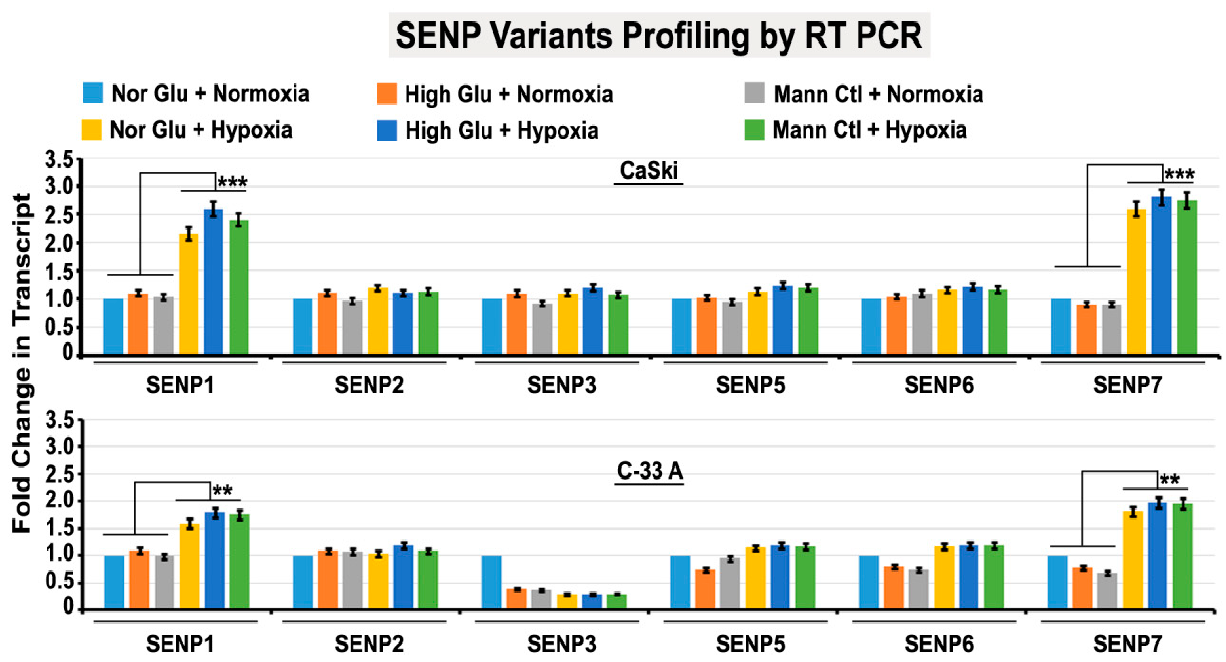
Figure 9. Acute hypoxia upregulates SUMOylation regulatory proteins SENP1 and SENP7. Tumour cells were subjected to the basic treatment conditions for 96 h. Real-Time-PCR-based data showed a significant upregulation in the transcript of SENP1 and SENP7 in acute hypoxia-induced conditions vs normoxia. All comparisons were made with NG normoxic condition unless indicated in the graph. Statistical significance is represented by p values: ** p ≤ 0.01 and *** p ≤ 0.001.